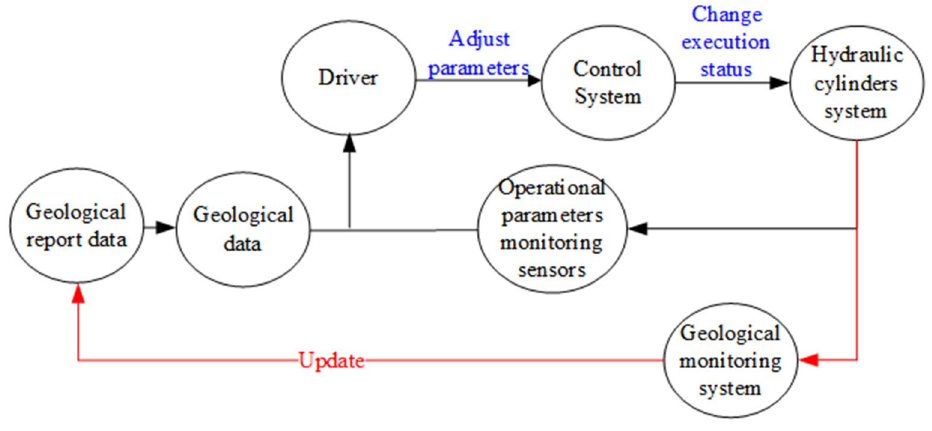
Figure 1. An overview of TBM